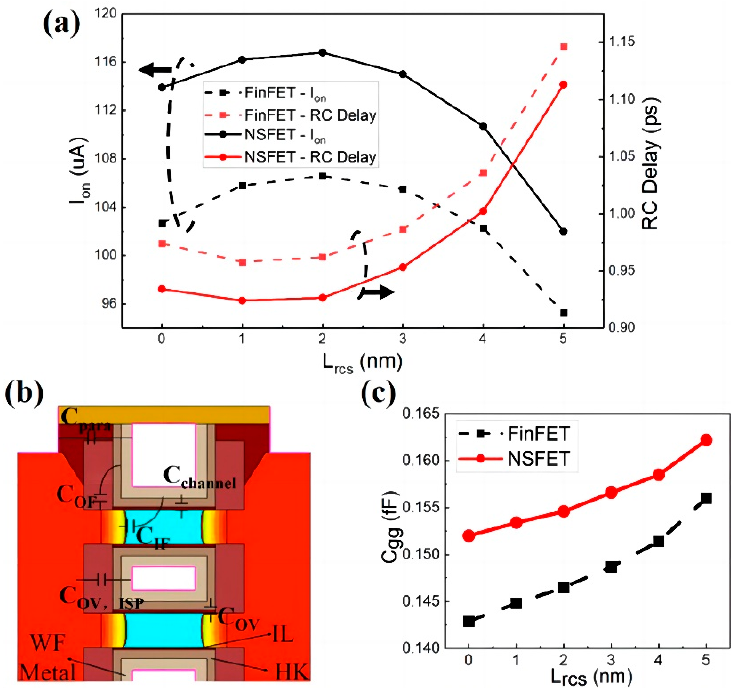
Figure 5. ( a ) I on and RC Delay comparison at fixed I off with varied L rcs ( b ) Schematic of intrinsic and parasitic gate capacitance components distribution in NSFET ( c ) C gg trends by varying L rcs for Fin and NS FETs.